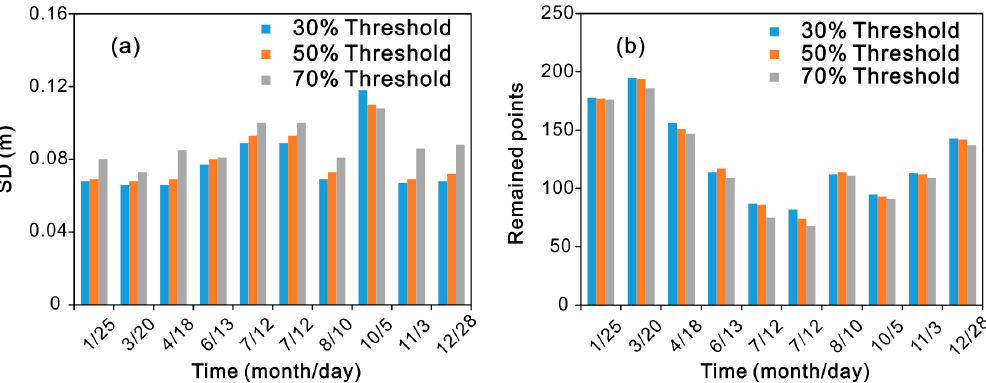
Figure 2. Comparison of the ( a ) Standard Deviation (SD) and ( b ) number of available observations generated by the Narrow Primary Peak Threshold (NPPT) retracker with three different thresholds.